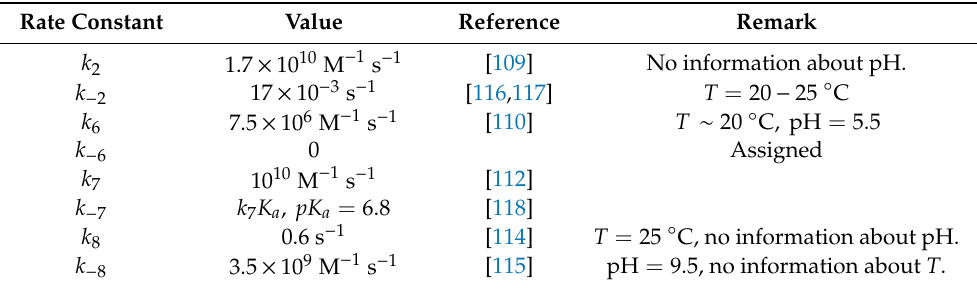
Table 1. Parameter values of the rate constants of the non-enzyme catalyzed reactions.